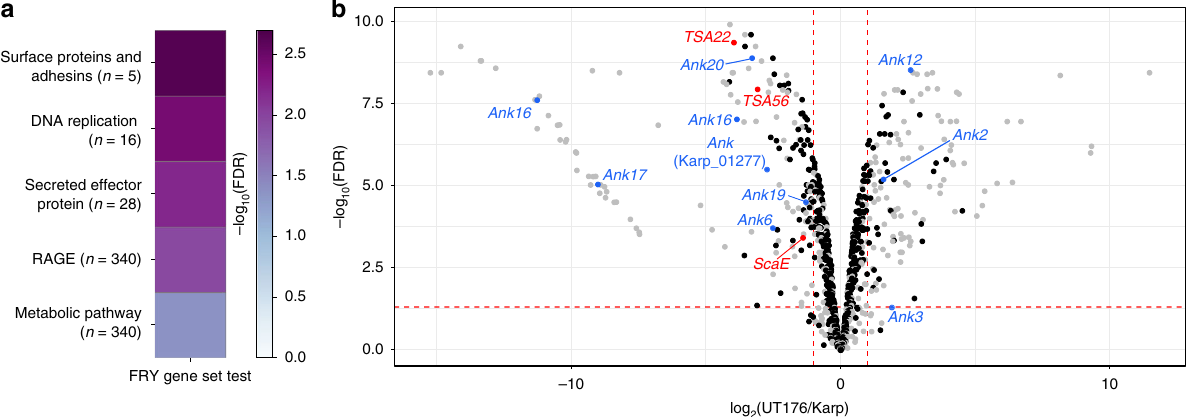
Fig. 4 Differential bacterial gene expression. a Heatmap illustrating pathways enriched in differentially expressed genes. All illustrated categories are more highly expressed in Karp. FDR-corrected p -values were calculated using the fry gene set enrichment test in the edgeR R package. b Volcano plot showing the differential expression of bacterial genes in Karp and UT176. Bacterial surface genes (red) and ankyrin-repeat-containing effector proteins (blue) with log fold change ≥ 1 are highlighted. Gray dots represent RAGE (rickettsial-ampli fi ed genetic element) genes. FDR-corrected two-sided p -values were calculated using the quasi-likelihood F -test in the edgeR R